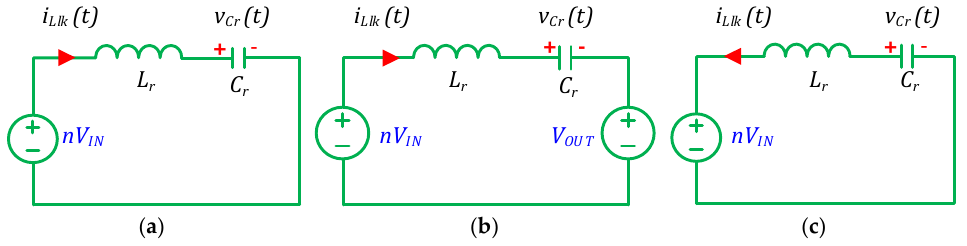
Figure 5. Equivalent circuits of the converter during the one-half cycle with the overlapping modulation at ∆𝑉 𝐶𝑟 > 2𝑛𝑉 𝐼𝑁 : ( a ) Mode I; ( b ) Mode II; ( c ) Mode III. Mode IV [ t 3 < t ≤ t 4 ]: The dead-time between the switches is applied during this mode. The switches S 1 and S 4 are turned off. The inductor current is still flowing in the same direction until the next time-interval. Also, the resonant capacitor continues discharging its energy in the inductor. The primary current has a non zero value.